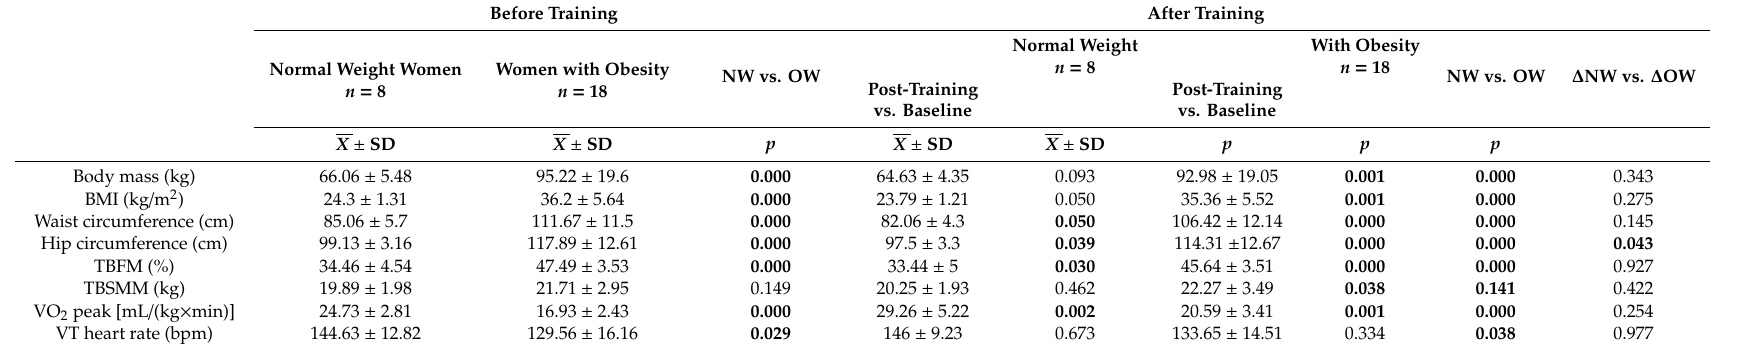
Table 2. Anthropometric, body composition, and physiological parameters in the study participants.